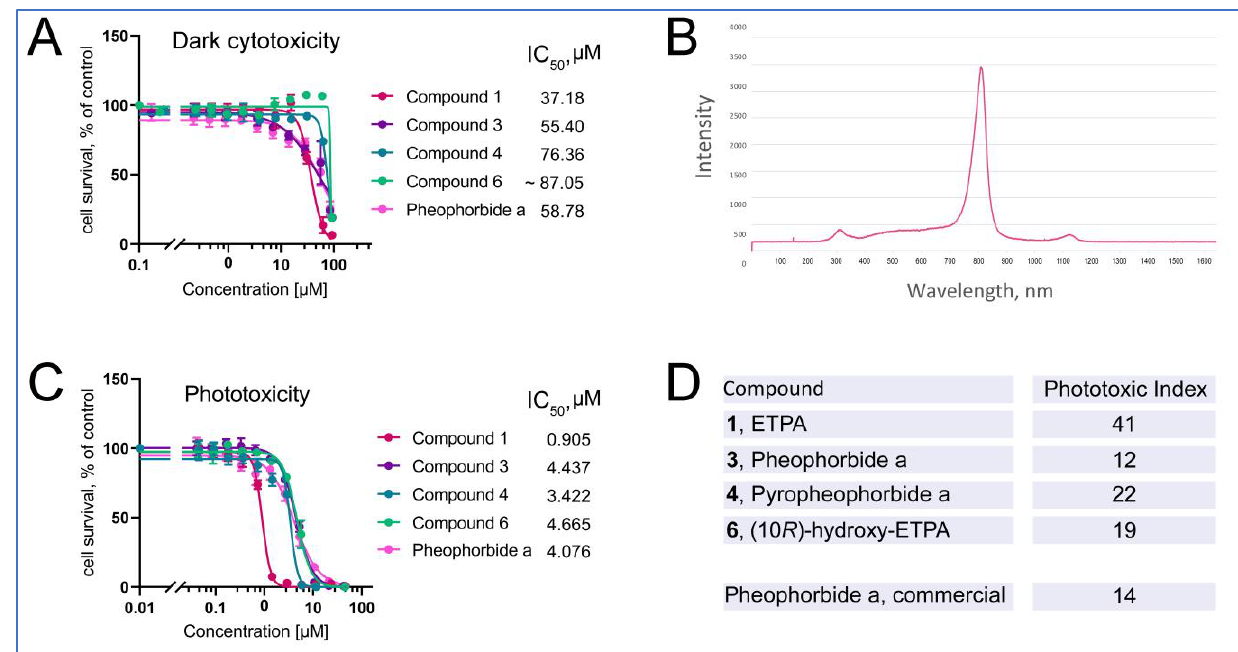
Figure 6. Phototoxicity of chlorins from O. sarsii against triple-negative breast cancer BT-20 cells. ( A ) Dark cytotoxicity of the compounds. ( B ) Emission spectrum of the LED lamp used in the phototoxicity experiment. ( C ) Phototoxicity of the compounds. ( D ) Phototoxic Index (PI) of the compounds. Commercial Pheophorbide a was used as a control in the experiments. The data are representatives of four independent experiments.